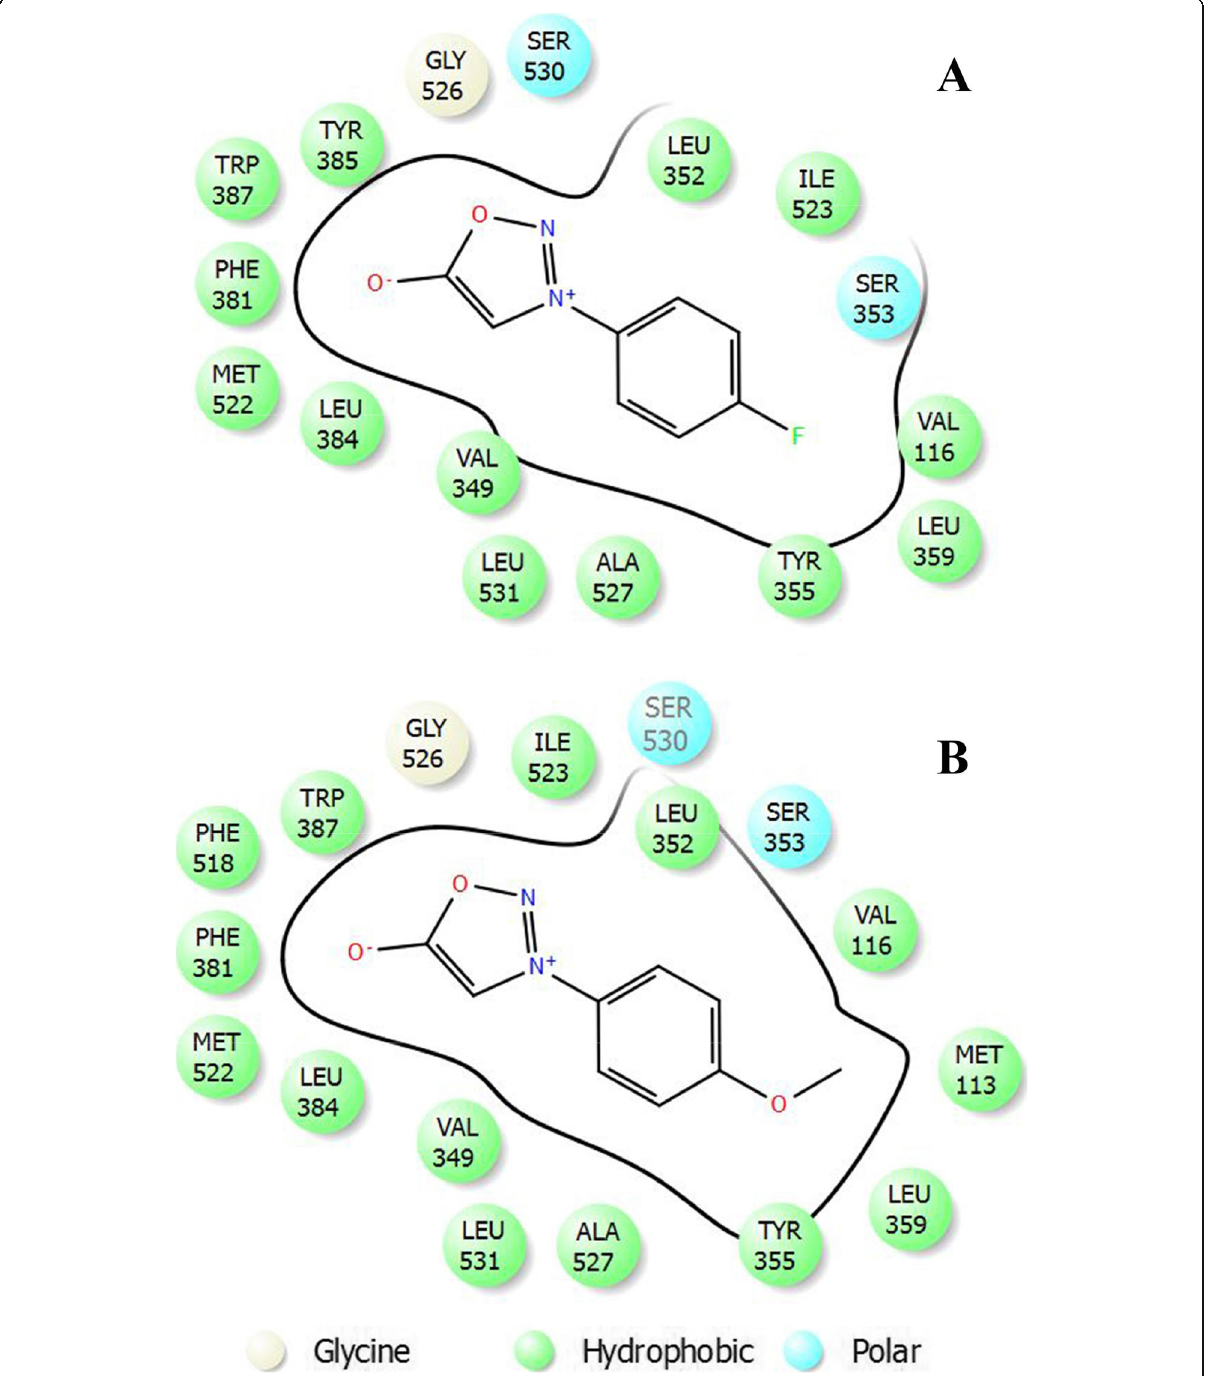
Fig. 10 Binding pose of 41 ( a ) and 39 ( b ) with the active site of